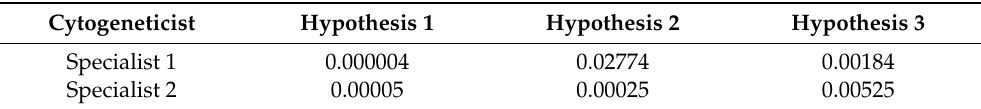
Table 1. This table shows a significant p-value on the following hypothesis: 1. Enhancing the images with our method will increase overall quality; 2. Enhancing the images with our method will increase the sharpness; 3. Enhancing the images with our method will increase the analysis time.